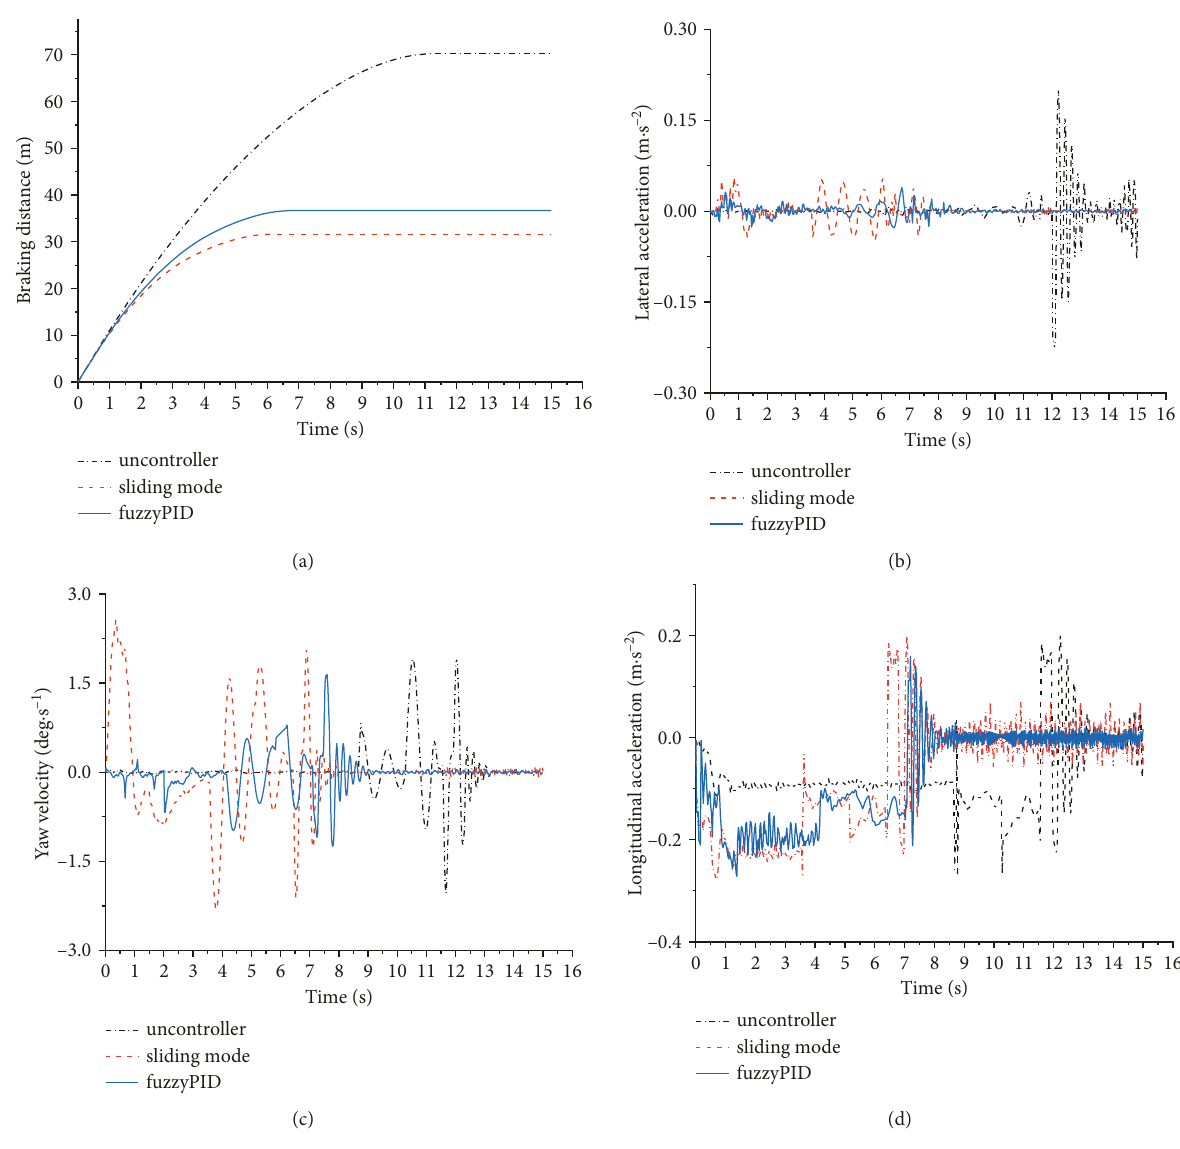
Figure 13: Simulation comparison diagram of different controls in long downhill with u � 0.5. (a) Braking distance. (b) Lateral acceleration. (c) Yaw velocity. (d) Longitudinal